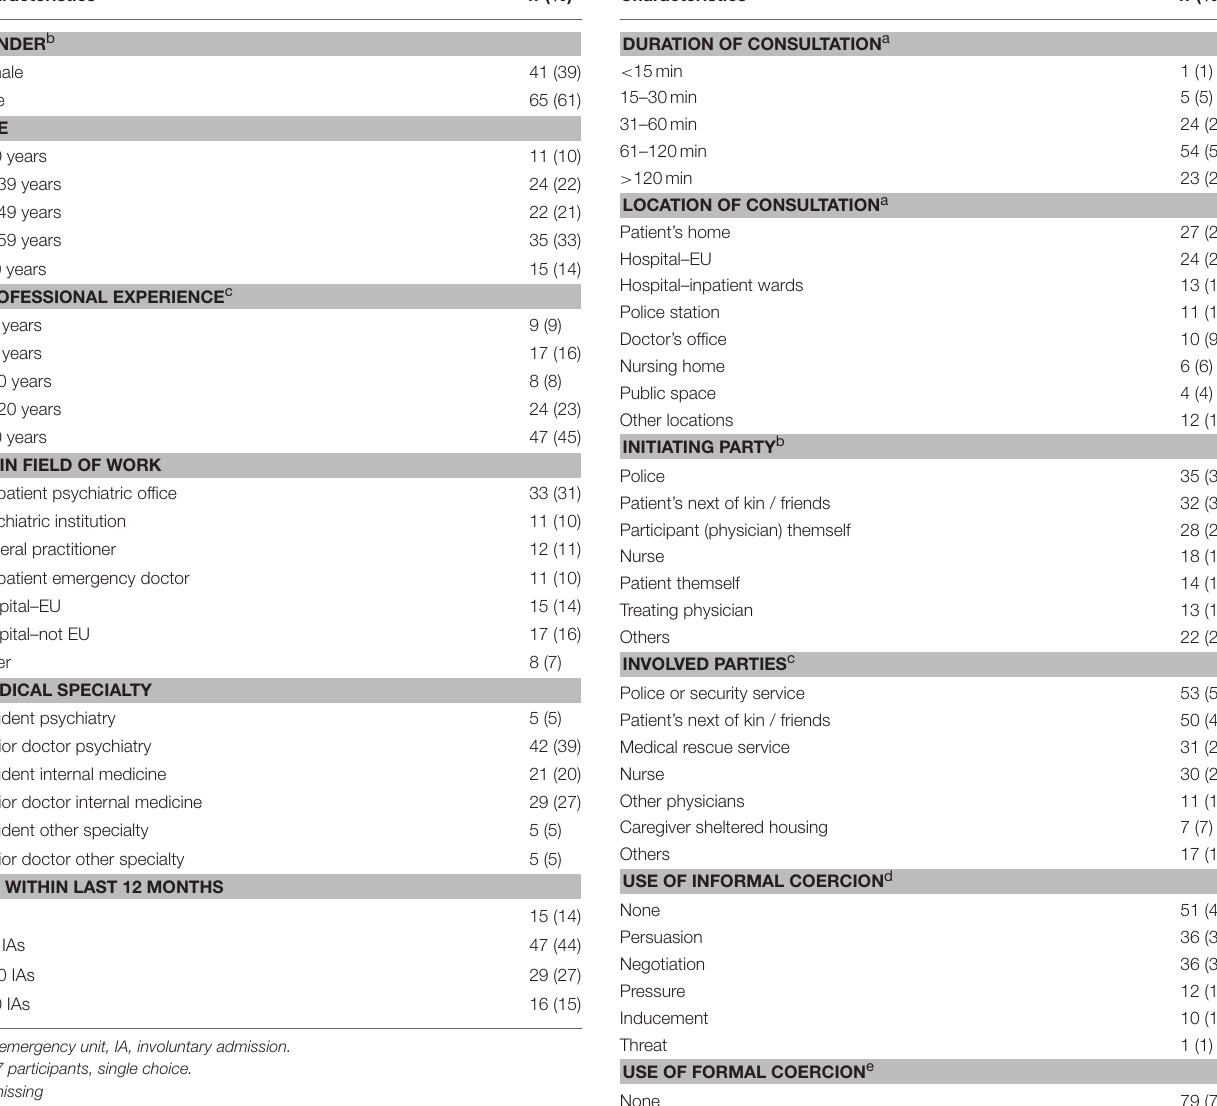
TABLE 1 | Participants’ socio-demographic data and professional background. Characteristics